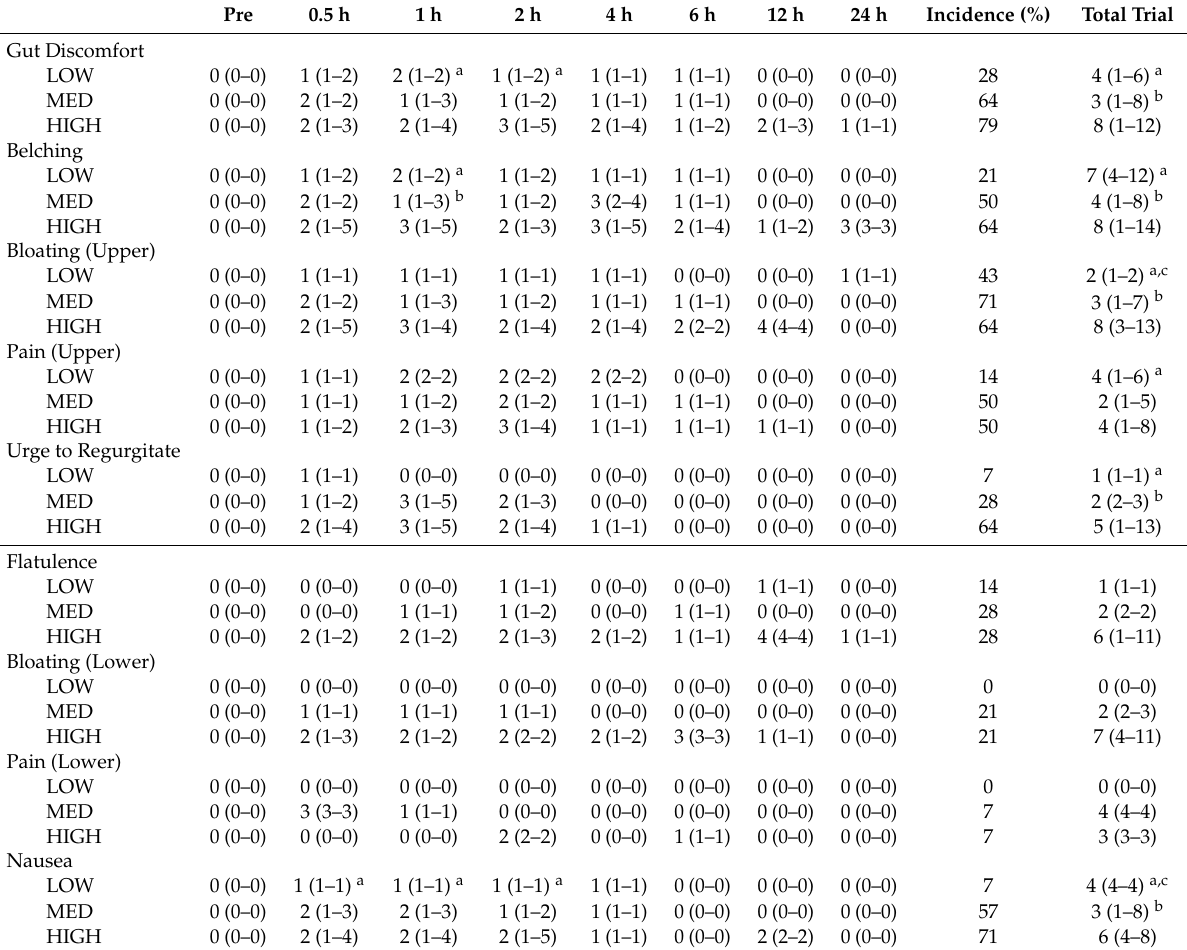
Table 3. Individual GI symptoms over time, incidence (%) and as a total 24-h accumulated score following LOW, MED or HIGH GLN